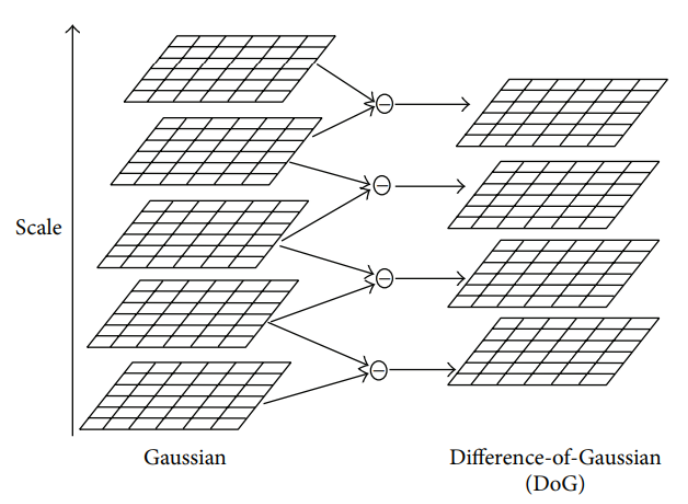
Figure 5. The left column represent the images resulted from the Gaussian functions with different values of K. The right column displays the Difference-of-Gaussian images that resulted from the subtraction of neighboring images. Adapted from [27].